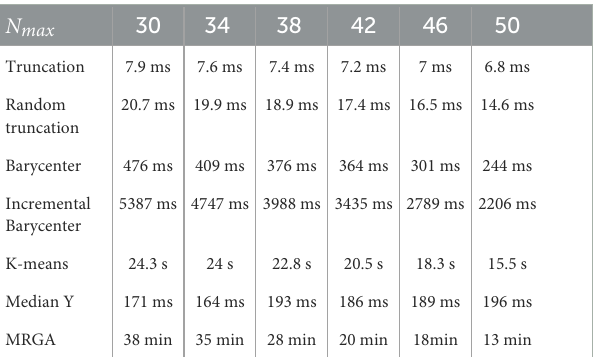
TABLE 2 Average computation time for all the minutiae sizes for each reduction